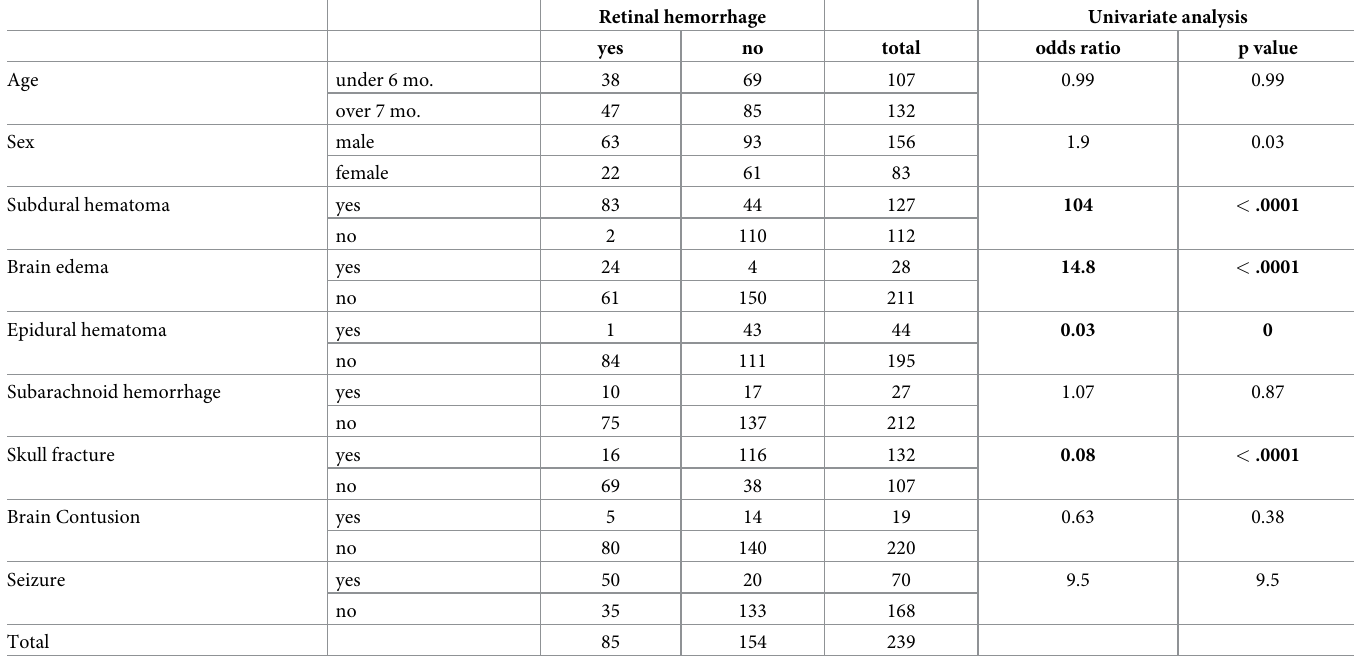
Table 1. Age, sex, and imaging findings of patients by the presence of retinal hemorrhage. Retinal hemorrhage Univariate